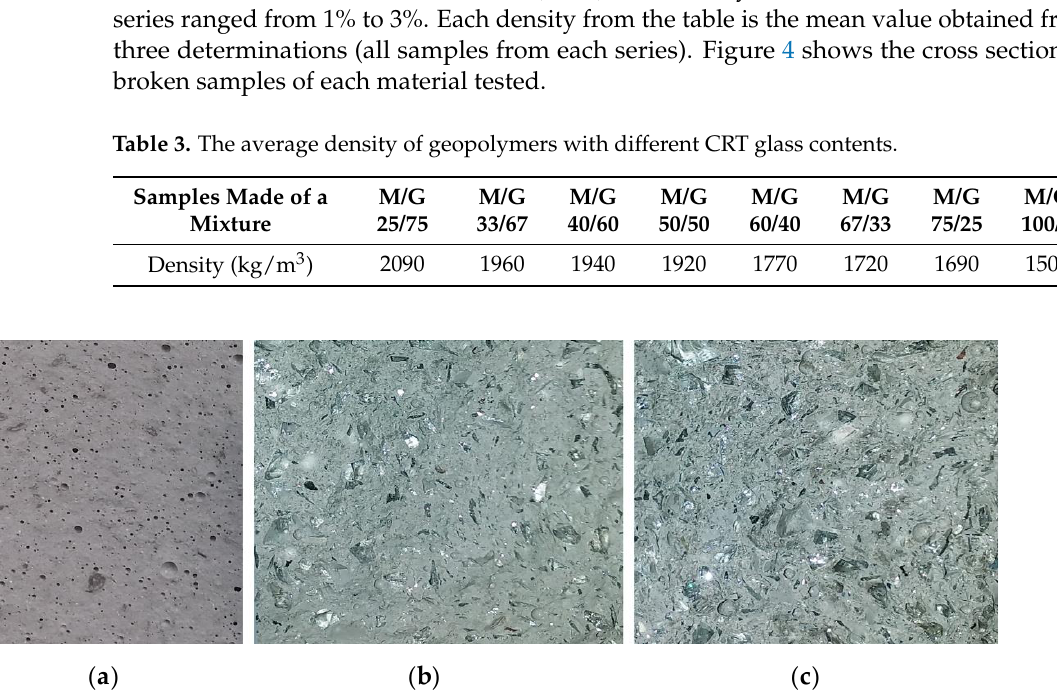
Figure 4. The cross section of a broken sample: ( a ) containing only metakaolin, ( b ) containing 50% CRT glass, and ( c ) containing 75% CRT glass.